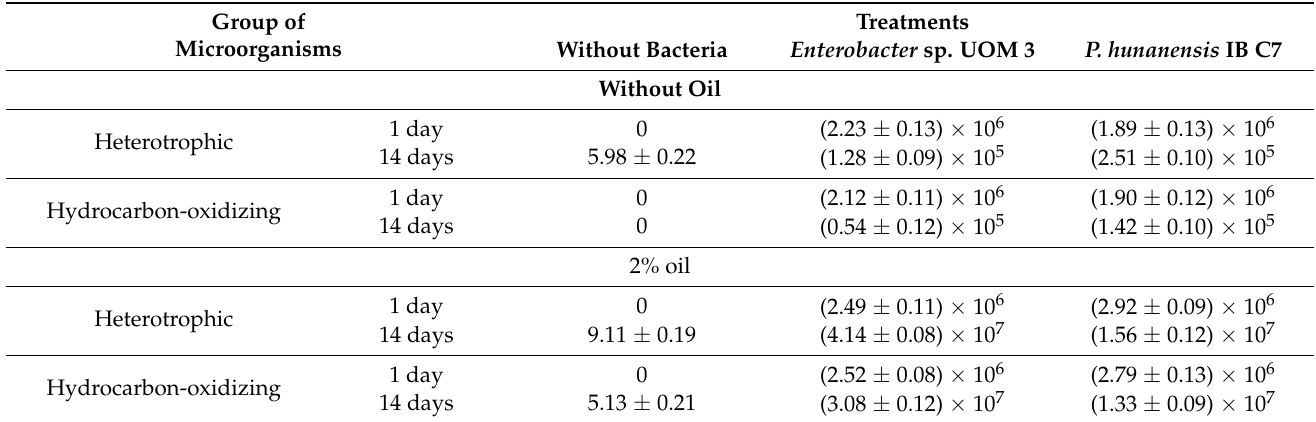
Table 1. The number of bacteria in the sand, CFU g − 1